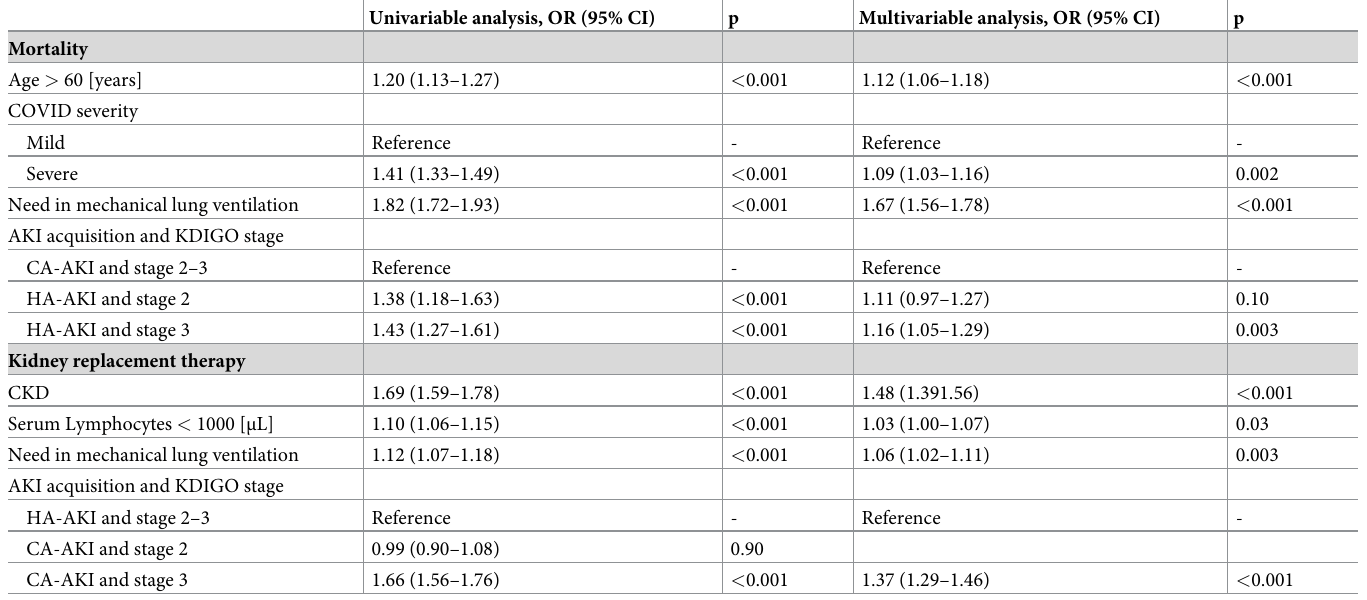
Table 3. Factors associated with mortality at 28-days of follow up and the requirement of kidney replacement therapy in hospitalized COVID patients, in the uni- variable and multivariable logistic regression model. Univariable analysis, OR (95% CI)